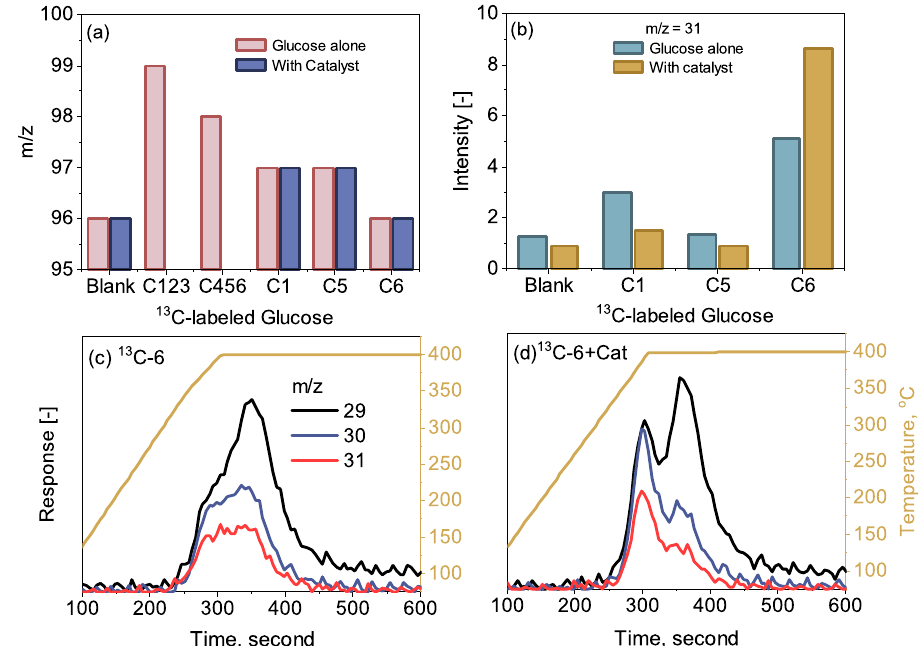
position. Panel d for the signals at the m/z of 29, 30 and 31 from the 13 C-labeled glucoseatC-6blendedwiththePd-PdO/ZnSO 4 catalyst.Thecatalystwastestedata mass ratio of eight to the